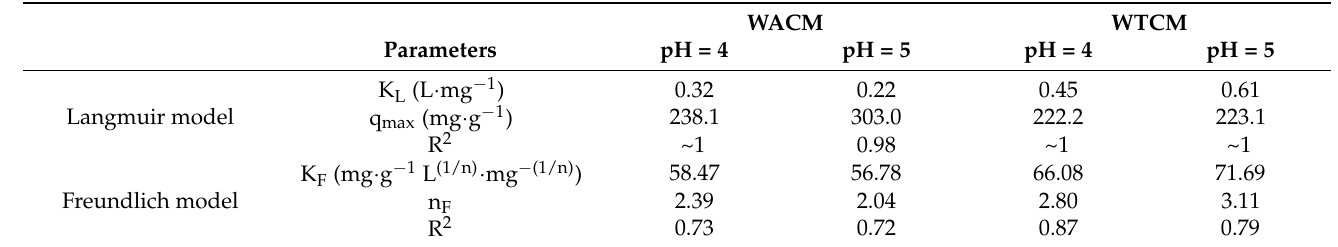
Table 2. Isothermal parameters for Pb(II) adsorption on WACM and WTCM, adjustment to Langmuir and Freundlich